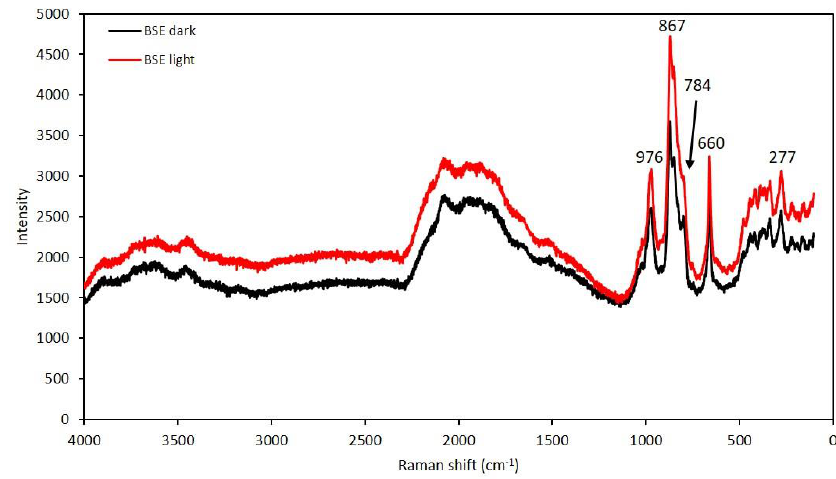
Figure 5. Raman spectra of kesebolite-(Ce) from different areas of the grain shown in Figure 2. − 1 The strongest band at 867 cm could tentatively be assigned to antisymmetric stretching of the − − 1 AsO 43 groups and the slightly weaker band at 784 cm to symmetric stretching mode of the same − 1 groups [20]. The strong band at 976 cm is likely related to the asymmetric vibration mode of the − 1 [SiO 3 ]-groups and the one at 660 cm to bending mode of the same functional group [21]. The weaker − 1 bands at lower wavenumbers (300 to 450 cm ) could be attributed to bending and stretching